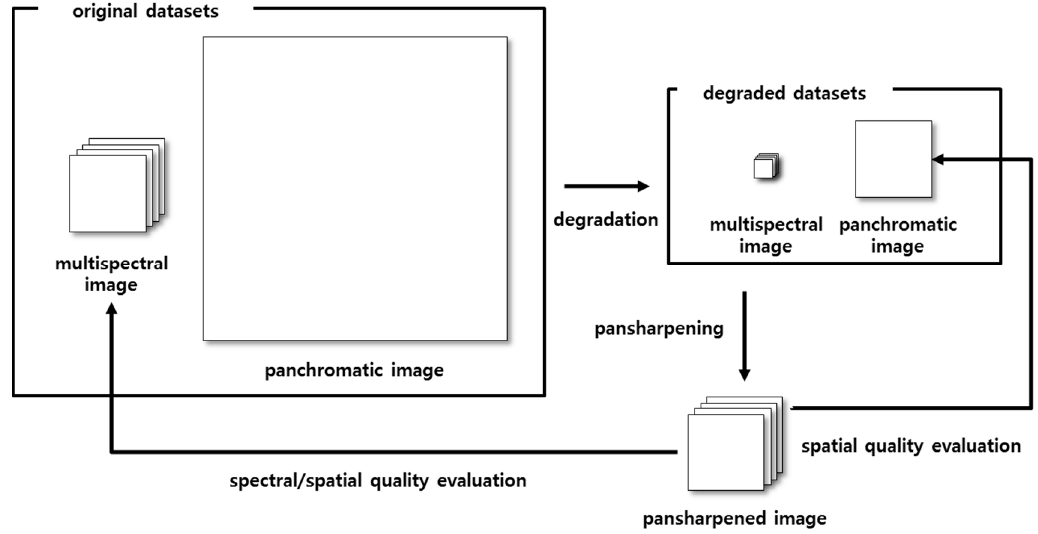
Figure 4. Workflow for assessing the synthesis property in evaluating the quality of pansharpened images.